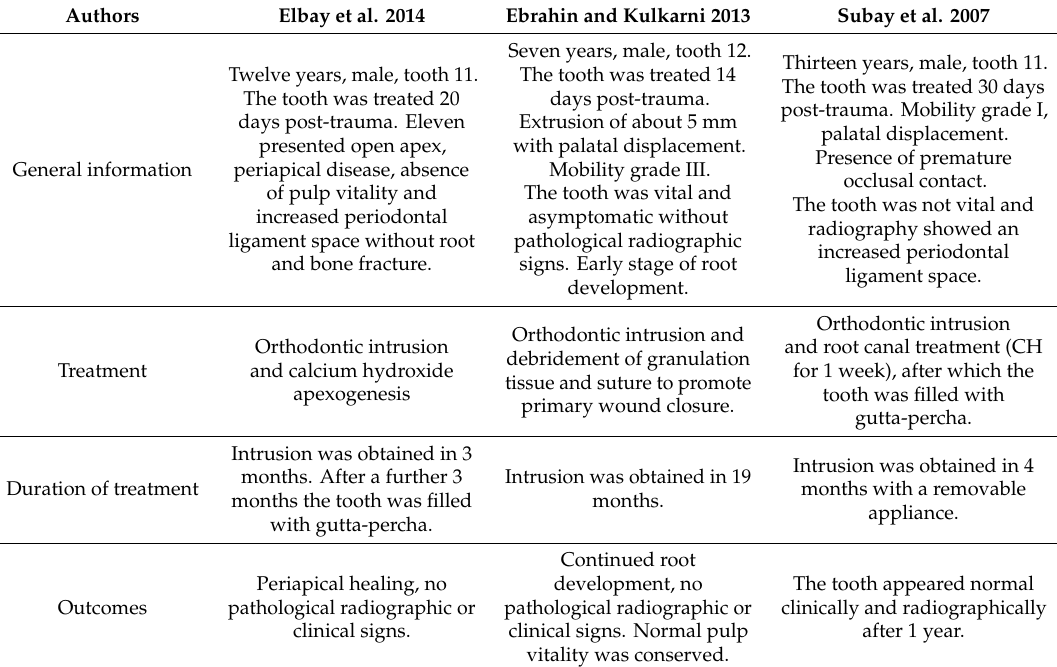
Table 5. The table shows the analysis of case report data on extrusive